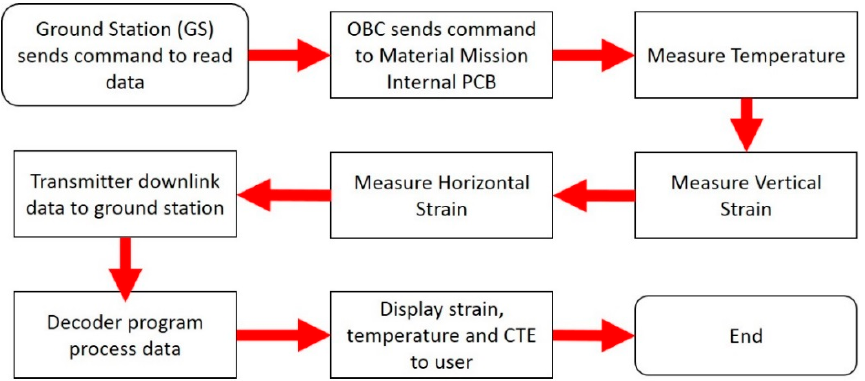
Figure 8. Overview of MM mission operations process